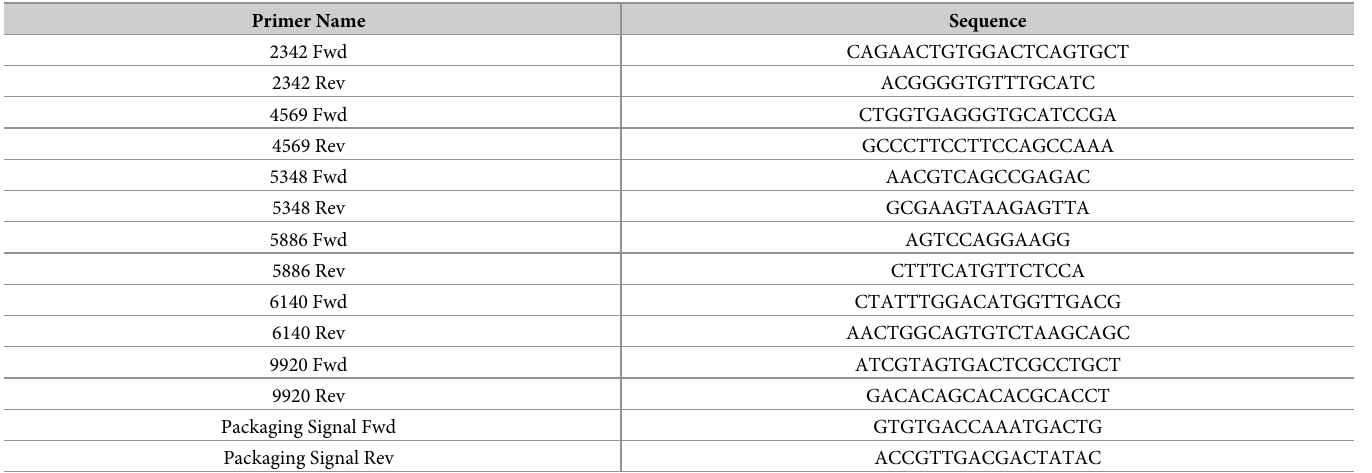
Table 2. Primers